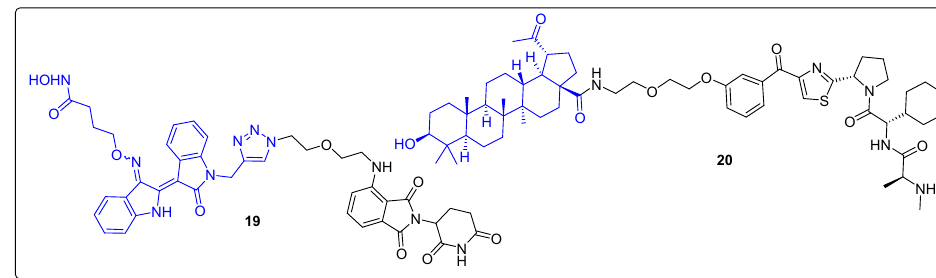
Figure 6. Natural product-based PROTACs.